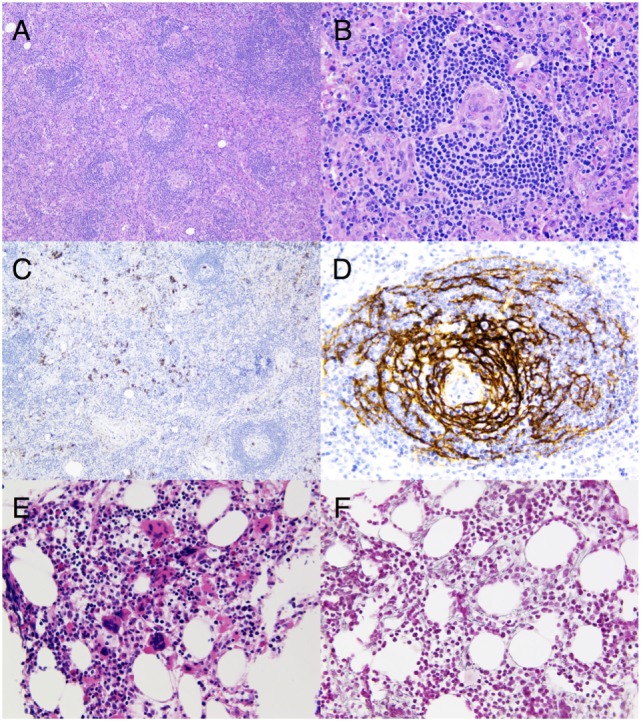
(A) Hematoxylin and eosin stain of a surgically removed axillary lymph node consistent with idiopathic multicentric Castleman’s disease (iMCD). Low magnification highlighting a prominent paracortex encircling atrophic secondary follicles (original magnification, ×10). (B) Hematoxylin and eosin stain focusing on an atrophic germinal center which is partially lymphocyte depleted and which is penetrated by a prominent, hyalinized blood vessel lined by plump endothelial cells with enlarged nuclei, giving the appearance of a lollipop. Note the marked vascular proliferation in the interfollicular areas (original magnification, ×40). (C) CD138 staining of sparsely scattered plasma cells in the interfollicular areas, less abundant compared to what is observed in the plasmacytic histopathological variant of iMCD (original magnification, ×10). (D) CD21 stain displaying a prominent network of follicular dendritic cells (FDCs) in an abnormal follicle with a concentric arrangement of the small lymphocytes of the mantle zone along with FDC nuclei (original magnification, ×40). (E) Hematoxylin and eosin stain of bone marrow showing megakaryocytic hyperplasia with a mixture of small hypolobated megakaryocytes and others having a multi-separated nucleus (original magnification, ×40). (F) Reticulin stain on the bone marrow trephine biopsy highlighting mild myelofibrosis (original magnification, ×40).